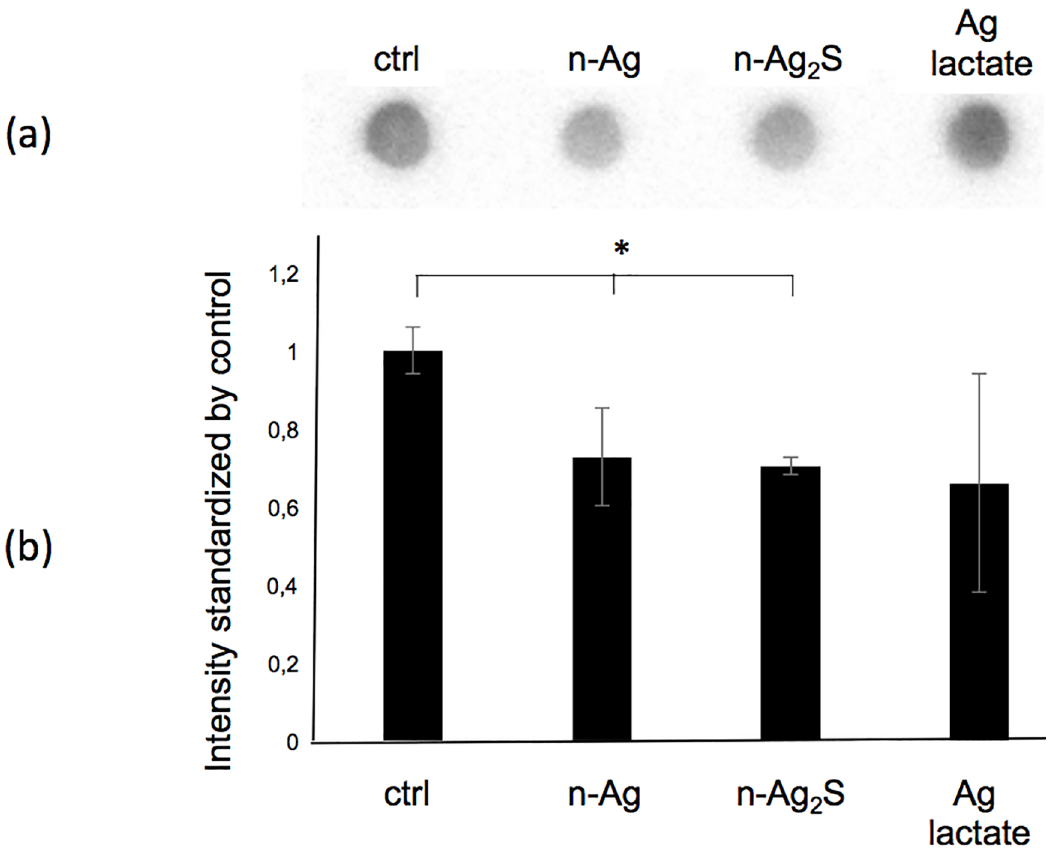
Fig 3. Less PGA is extracted from growth supernatant after exposure of Bacillussubtilis to silver nanoparticles (n-Ag). (a) Representative dot blot of the extracted PGA. (b) Quantification of dot blot intensity after stress to Bacillus subtilis . The intensities were normalised by the control and the amount of proteins. Error bars ± 1 standard deviation ( n (cid:21) 3). Asterisks ( (cid:3) ) indicate significant differences vs the control ( p < 0.05).